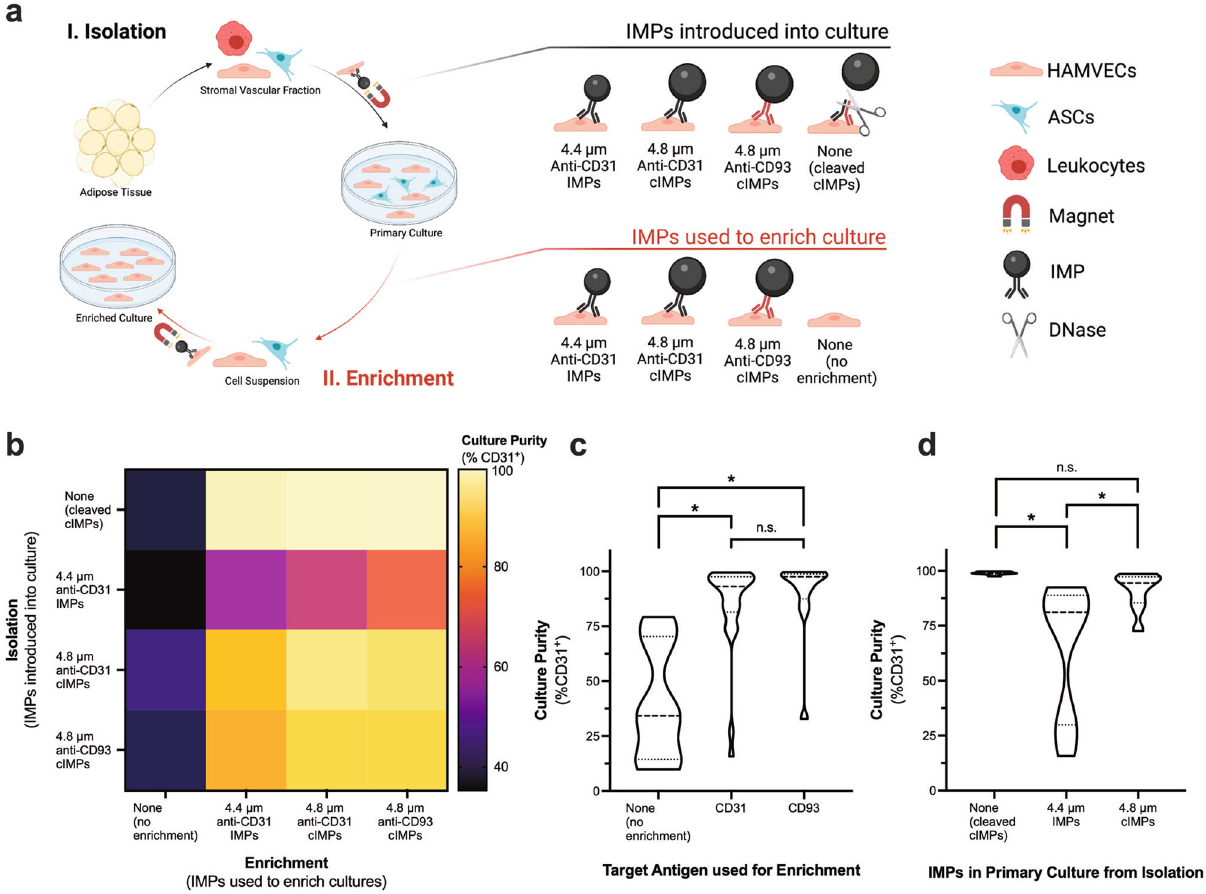
Fig. 9 Mitigating the non-speci fi c uptake of immunomagnetic microparticles (IMPs) by adipose tissue-derived stromal/stem cells (ASCs) facilitates the enrichment of human adipose tissue-derived microvascular endothelial cells (HAMVECs). a Schematic depicting the magnet-assisted cell sorting (MACS) procedure used to acquire HAMVECs from enzymatically digested fat, as well as the different combinations of IMPs tested for the isolation and enrichment of HAMVECs using an in vitro model of their contaminated primary cultures. Speci fi cally, HAMVECs and ASCs were seeded in a 9:1 proportion with or without IMPs to recapitulate their potential exclusion from primary cultures, made possible by enzymatically cleaving the deoxyribonucleic acid linkers coupling the antibodies to the superparamagnetic microparticles (i.e. cleavable (c)IMPs). Their enrichment was performed after 4 days, and their purities (% CD31 + ) were evaluated after a total of 7 days. Created with BioRender.com b Effects of alternative target antigens (CD31 vs. CD93), sizes (4.4 µ m IMPs vs. 4.8 µ m cIMPs), and exposures (introduced vs. excluded from cultures) of IMPs on the enrichment ef fi cacy of the MACS procedure. Values represent mean. c Effect of the target antigen on the enrichment ef fi cacy of the MACS procedure. ‘ None ’ depicts the distribution of purities of co- cultures that were not subjected to MACS after 4 days; ‘ CD31 ’ , those that were enriched using anti-CD31 IMPs or anti-CD31 cIMPs; and, ‘ CD93 ’ , those that were enriched using anti-CD93 cIMPs. d Effect of introducing IMPs into primary cultures on the ef fi cacy of their sequential enrichment. ‘ None ’ depicts the distribution of purities of enriched co-cultures that were free of IMPs and cIMPs at the time of MACS; ‘ 4.4 µ m IMPs ’ , those that were laden with the smaller anti-CD31 IMPs; and, ‘ 4.8 µ m cIMPs ’ , those that were laden with the larger anti-CD31 cIMPs or anti-CD93 cIMPs. * p < 0.05; ns represents not statistically signi fi cant. Dashed lines in the violin plots represent median; dotted lines, quartiles; and, horizontal solid lines, range. The experiment was performed in biological triplicate, using cells derived from three different donors ( n = 3 biologically independent